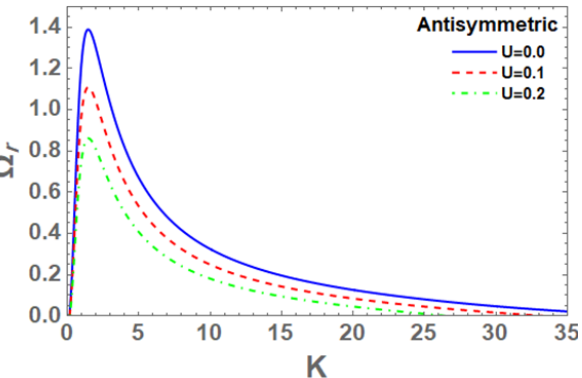
Figure 10. Change in non-dimensional growth rate Ω r with non-dimensional wave number K for varied gas to liquid velocity values U < 1, when We = 1000; Oh = 0.1; N = 1; ρ = 0.01; v = 0.2; κ 1 = 2; ˜ (cid:101) l = 0.3; ˜ (cid:101) g = 0.1; E = 3; V (cid:48) = 0.1; ε = 0.5, for axisymmetric disturbance